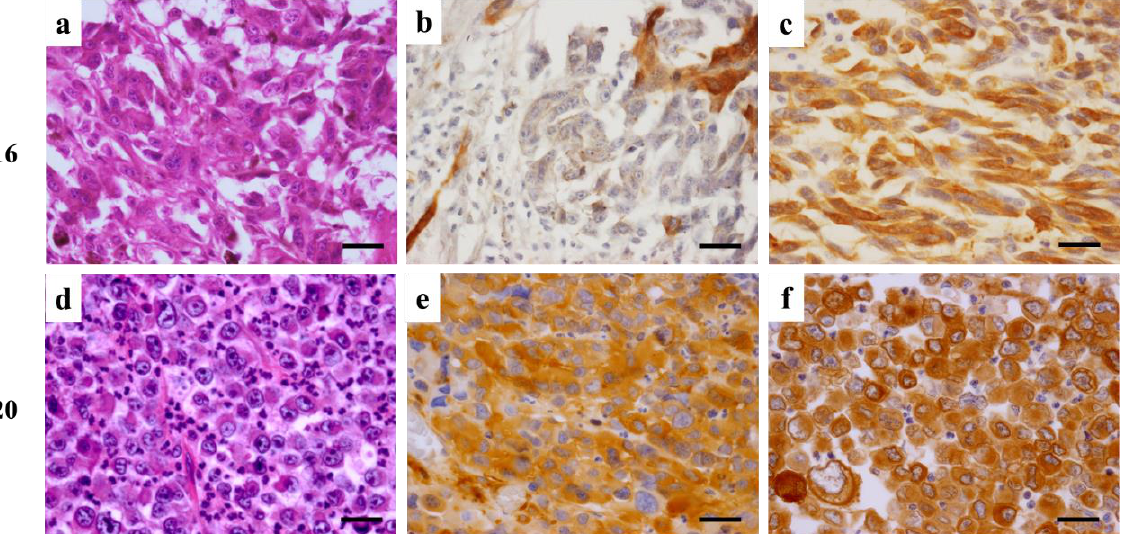
Figure 5. HE and Fascin immunohistochemical staining images of Case 16 and 20. ( a – c ) Hematoxylin and eosin staining ( a ) and Fascin immunohistochemical staining ( b ) at the primary tumor, and Fascin immunohistochemical staining ( c ) at metastasis of Case 16. A 76-year-old woman was diagnosed with melanoma on the third finger and received the finger amputation in January 2017. She was followed up regularly without further treatment. In May 2020, metastasis at axillary lymph node was detected and surgical treatment was performed. ( a , b ) At the primary lesion, a proliferation of atypical melanocytes with round nuclei is observed. ( b ) The intensity and proportion of Fascin staining are evaluated as +1 and +1, respectively. ( c ) At metastasis, atypical melanocytes with short spindle-shaped nuclei are dominant, and melanin granules are observed in some cells. The intensity and proportion of Fascin staining are evaluated as +3 and +5, respectively. ( d – f ) Hematoxylin and eosin staining ( d ) and Fascin immunohistochemical staining ( e ) at the primary tumor, and Fascin immunohistochemical staining ( f ) at metastasis of Case 20. A 77-year-old man had an infection on the thumb in May 2018, and was diagnosed with melanoma in November 2018. The thumb amputation was performed, and no metastasis was detected via positron emission tomography (PET) before surgery. Due to having been treated by chemotherapy for multiple myeloma, systemic chemotherapy for melanoma was not administered. However, in PET of a month later, metastasis at the axillary lymph node was detected, and surgical treatment was performed in February 2019. ( d , e ) At the primary lesion, a solid proliferation of tumor cells is observed with the large round nuclei and distinctive nuclear bodies. ( e ) The intensity and proportion of Fascin staining are evalu- ated as +2 and +5, respectively. ( f ) At the axillary lymph node metastasis, the structure of lymph nodes is unclear, and severe infiltration of tumor cells out of the lymph node can be observed. The intensity and proportion of Fascin staining are evaluated as +3 and +5, respectively. (Scale bars: 50 μm)